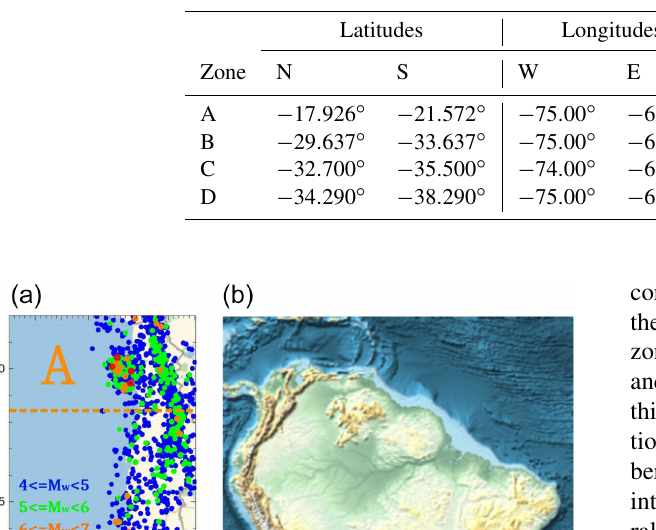
Table 1. Geographical definition of the four zones considered in this study. The strongest seismic event in each zone is identified at the end. Zone C lacks a very strong seism during recent years which is indicated by the use of parenthesis for the strongest seism here. The geographical coordinates and time windows are explained and defined in the text.